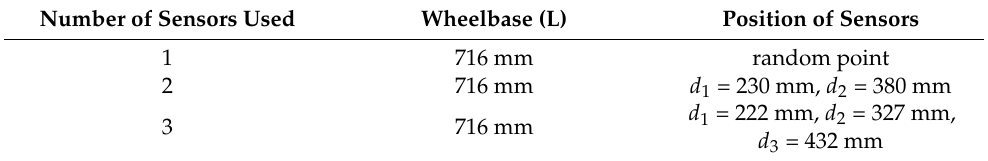
Table 1. Summary of optimal sensor positions when increasing the number of sensors used. Number of Sensors Used